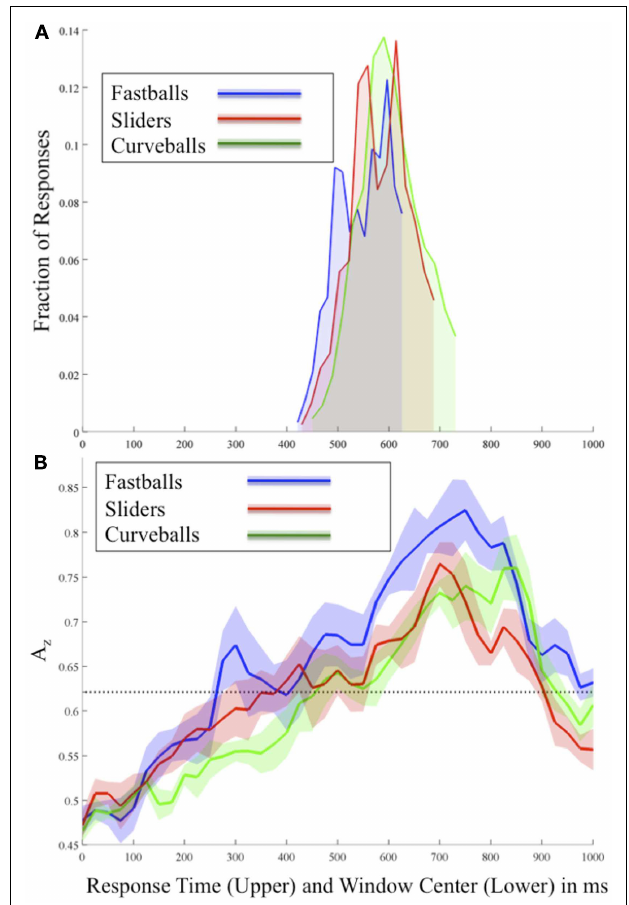
FIGURE 2 | (A) Behavioral and (B) stimulus-locked EEG discrimination results for each pitch averaged across all subjects. In (B) each A z curve shows the mean and standard error bands computed using leave-one-out discrimination for the indicated pitch vs. other pitches (e.g., for fastballs, the discrimination is between fastballs and not-fastballs; i.e., curveballs and sliders).The significance line (dotted) is corrected for multiple comparisons (line at p = 0.05 Bonferroni corrected for 41 time window comparisons). Note the two plots are time aligned and have the same time-scale so as to compare the timing of EEG discrimination and behavioral